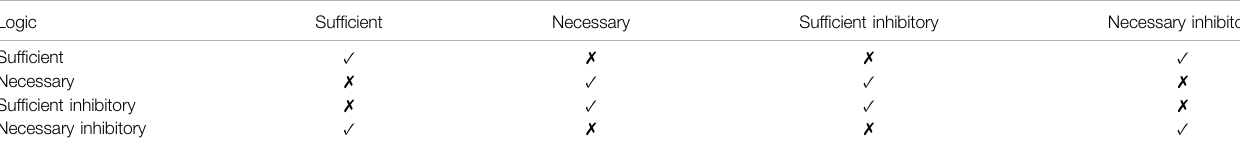
TABLE 2 | Compatibility of the causal logic implications of regulator nodes. The matrix lists the compatibility of different regulators with varying causal logic implications with ✓ ’ s and 7 ’ s. The fi rst row and the fi rst column denote the logic implications of different regulators. A check ( ✓ ) entry denotes that the logic implications in the corresponding row title and column title are compatible while a cross ( 7 ) entry denotes that they are incompatible.